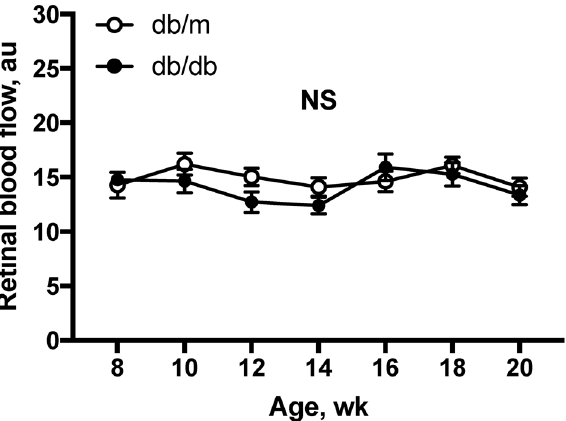
Figure 2. Retinal blood flow in db/db and db/m mice from 8 to 20 weeks old. Retinal blood flow (a.u) remained stable in both groups throughout, by one-way repeated measures ANOVA (P = 0.37 for db/m mice and P = 0.47 for db/db mice). No differences in resting retinal blood flows were observed (two-way repeated measures ANOVA). NS not significant between groups and within group.